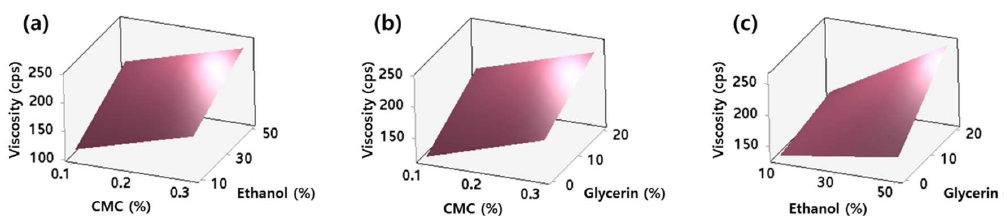
Figure 3. Response surface plots showing the effect of ( a ) CMC ( x 1 ) and ethanol ( x 2 ); ( b ) CMC ( x 1 ) and glycerin ( x 3 ); and ( c ) ethanol ( x 2 ) and glycerin ( x 3 ) on viscosity ( y 1 ). The hold values of CMC, ethanol, and glycerin were set at 0.2%, 30%, and 10%, respectively.